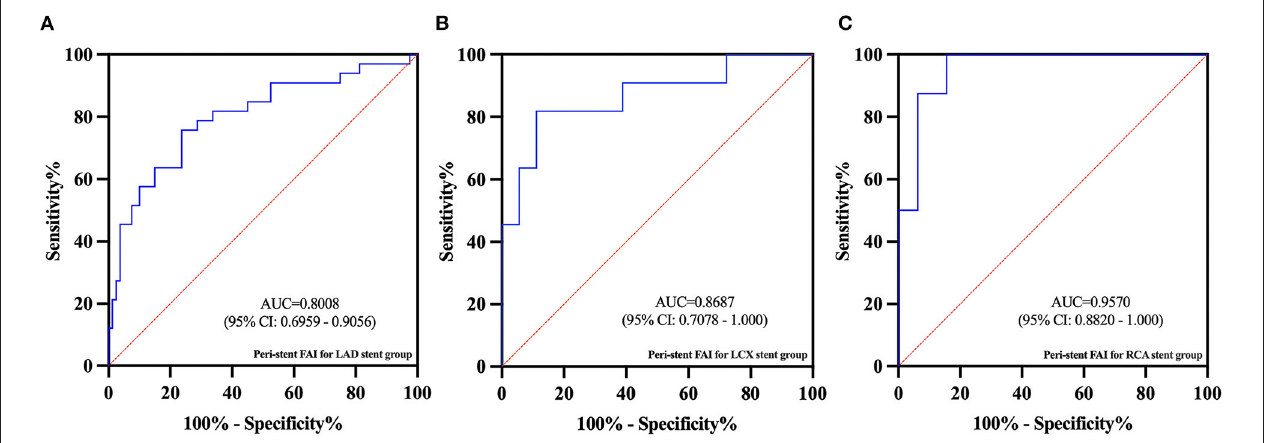
FIGURE 6 | In the subgroup ROC analysis, the AUC values for ISR predicted by peri-stent FAI in the LAD (A) , LCx (B) , and RCA (C) subgroups were 0.80, 0.87, and 0.96, respectively.